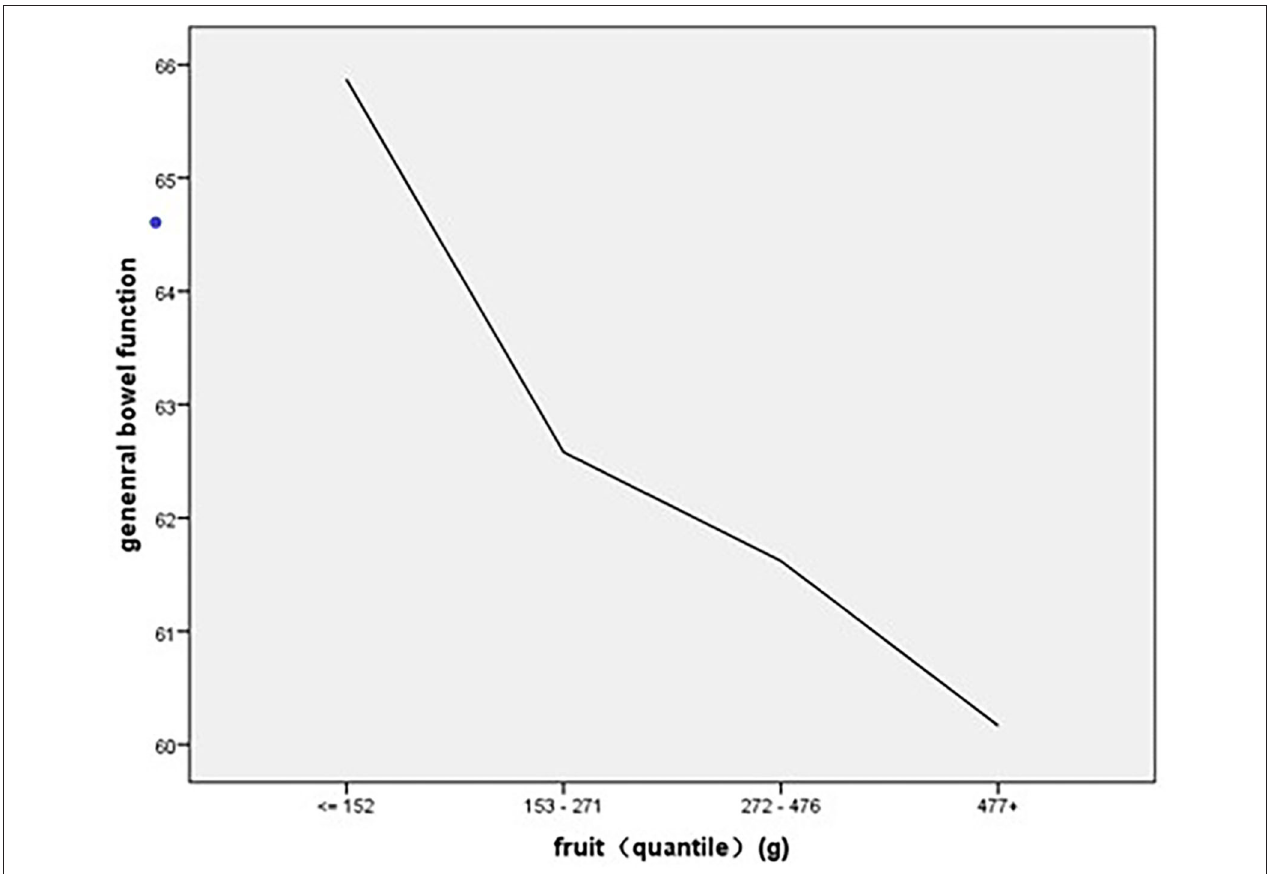
FIGURE 1 | The association of stratified quintiles of consumption of fruits with general bowel